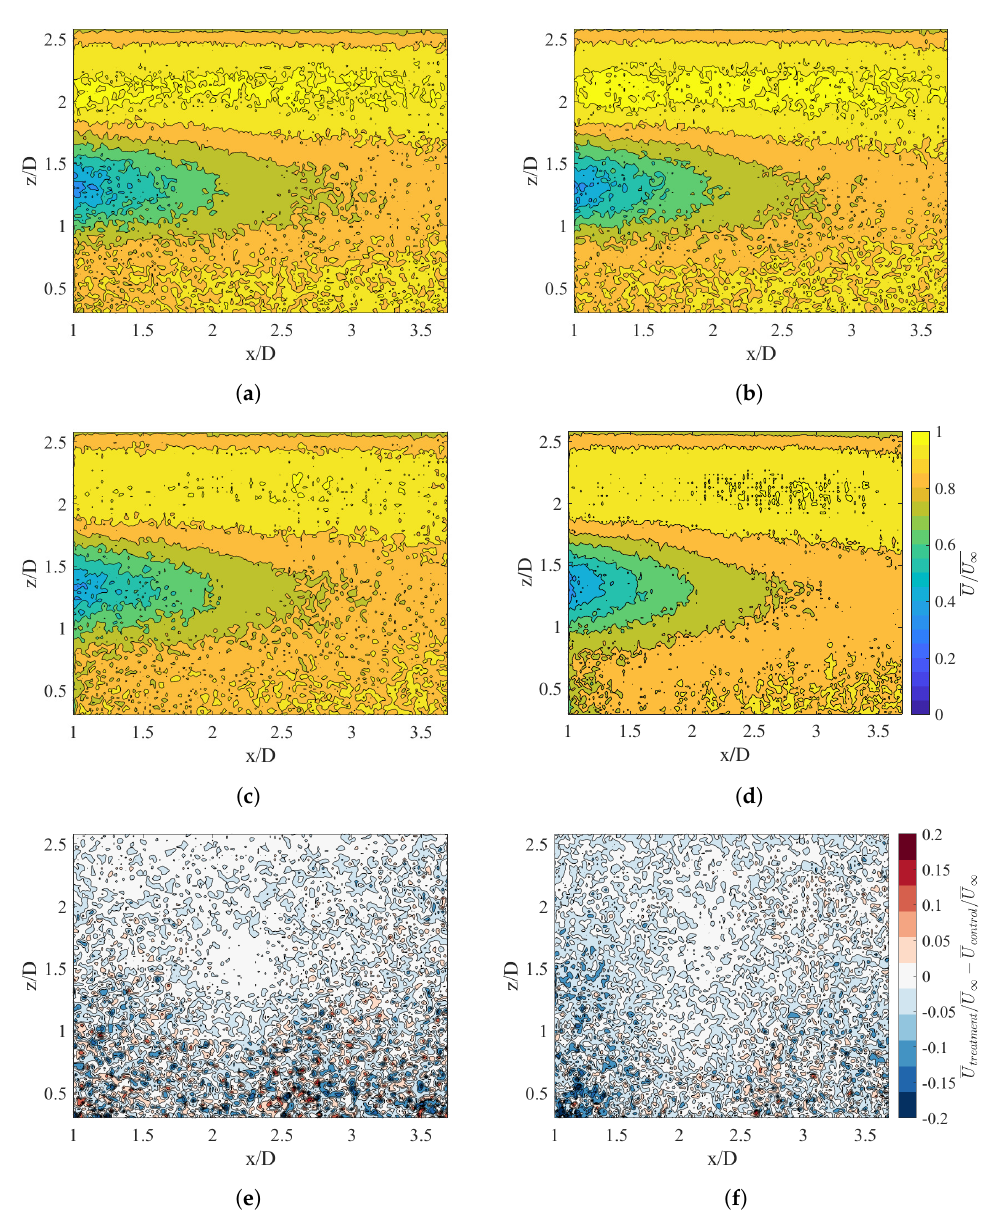
Figure 10. ( a – d ) Contours of the PIV recorded time-averaged streamwise velocity along the cen- terline of the array normalized by the time-averaged freestream velocity. The intersection of the upstream rotor plane and the flume bed is at coordinate (0,0); ( a ) control case between rows one and two; ( b ) control case between rows two and three; ( c ) treatment case between rows one and two; ( d ) treatment case between rows two and three; and ( e , f ) the differences between treatment and control between rows one and two and two and three,